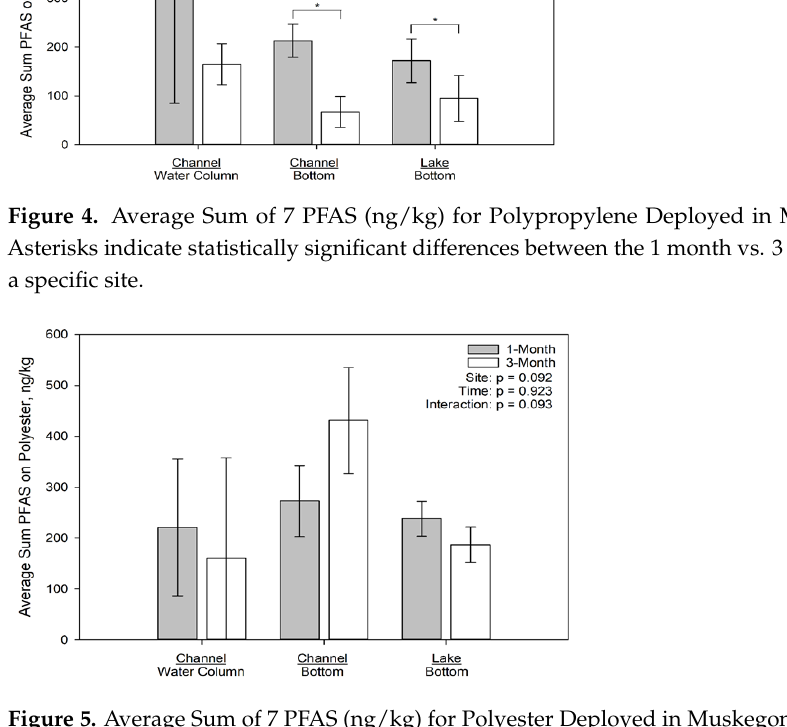
Figure 5. Average Sum of 7 PFAS (ng/kg) for Polyester Deployed in Muskegon Lake, MI.